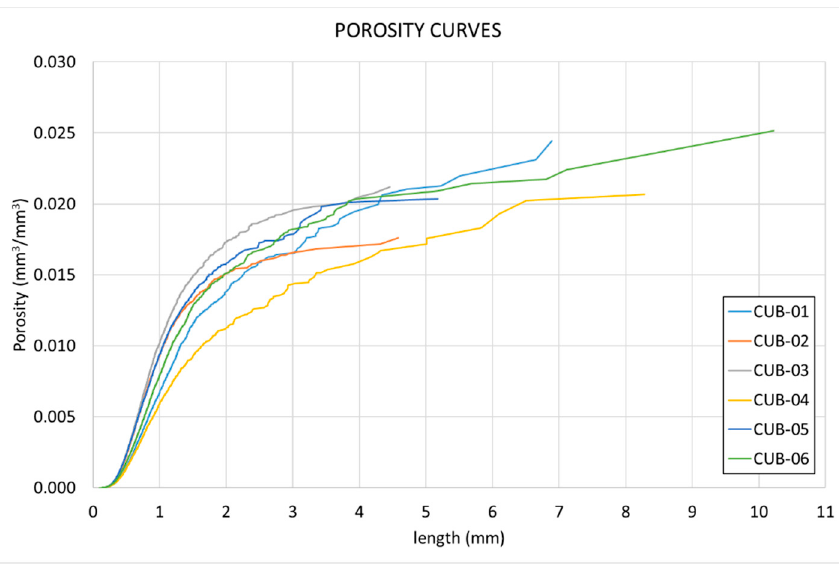
Figure 17. Porosity curves.